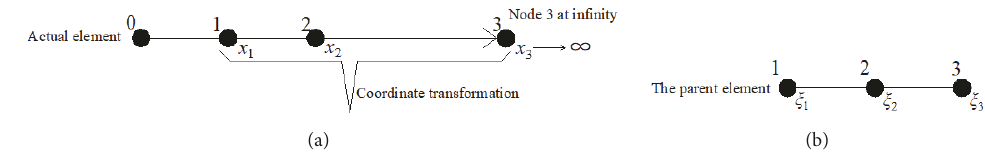
Figure 1: Static mapping of 1D infinite element.